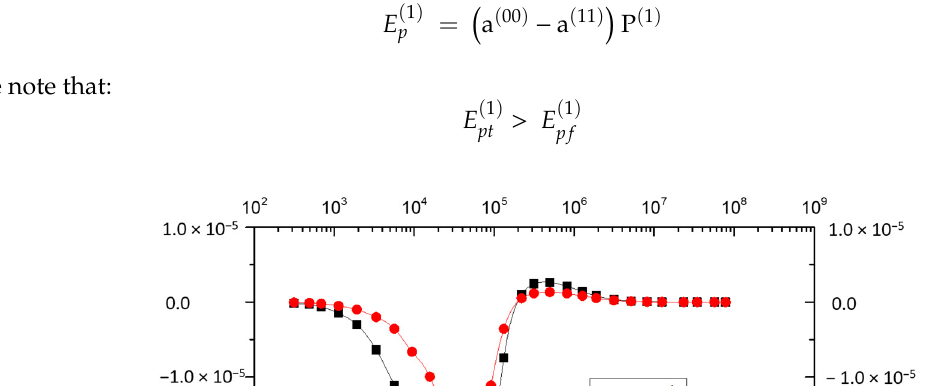
Figure 4. Comparison between normal (black line) and cancerous cells (red line) of the field E (1) as a function of the frequency of perturbation, see Equation (A6).